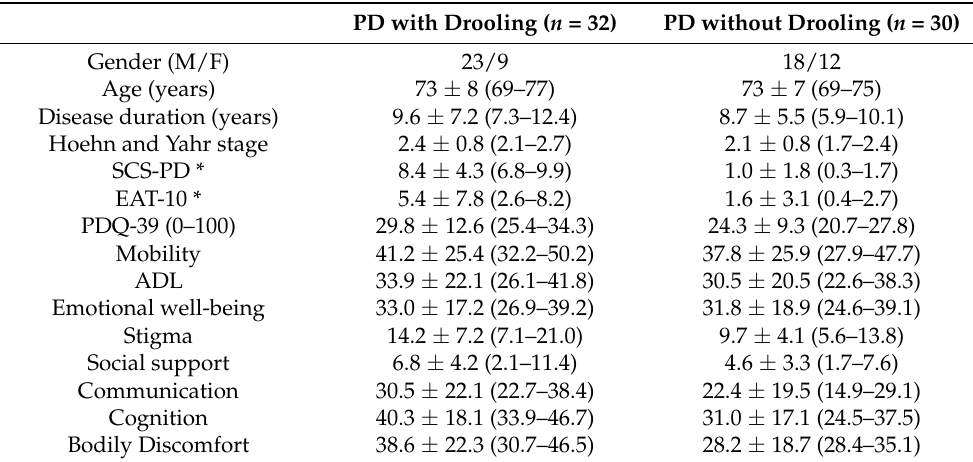
Table 1. Clinical and demographic features of patients with Parkinson’s disease with and with- out